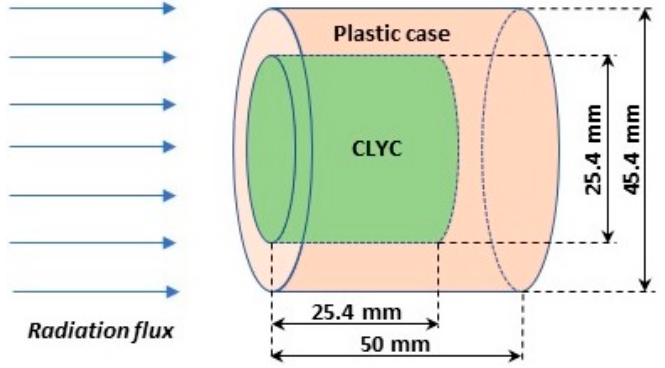
Figure 12. Schematics of the CLYC model in FLUKA.